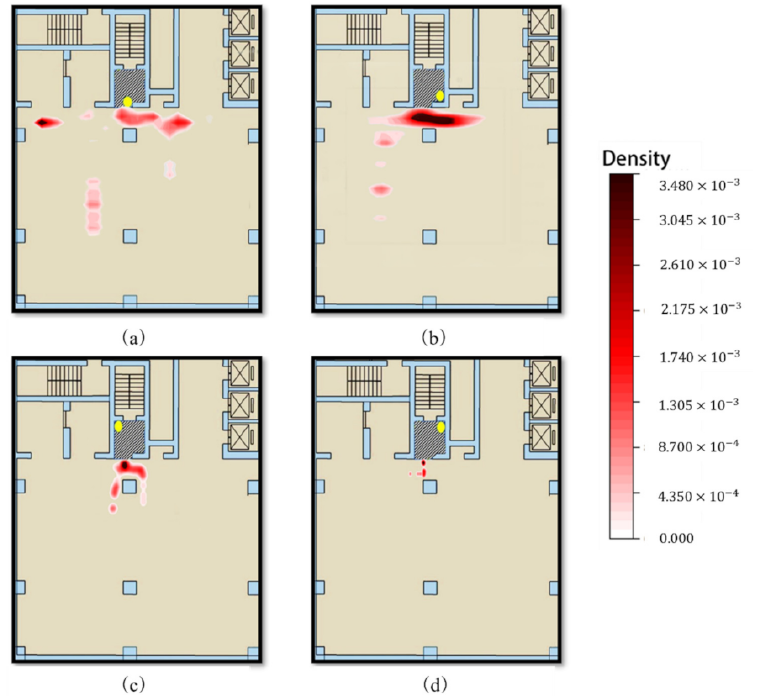
Figure 6. Heat map of hazard alarm reception locations (when the BLE signal generating beacon sensor was deployed at Location 1 ( a ), Location 2 ( b ), Location 3 ( c ) and Location 4 ( d